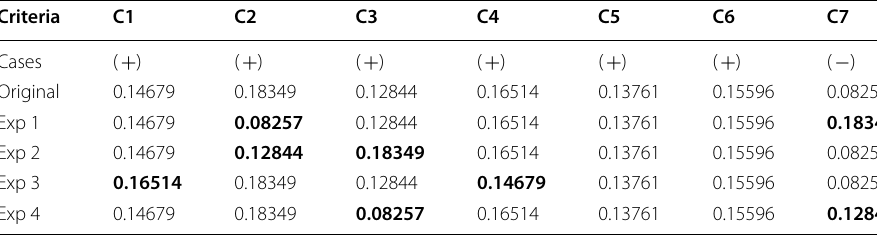
Table 15 Experiments for the sensitivity analysis Criteria